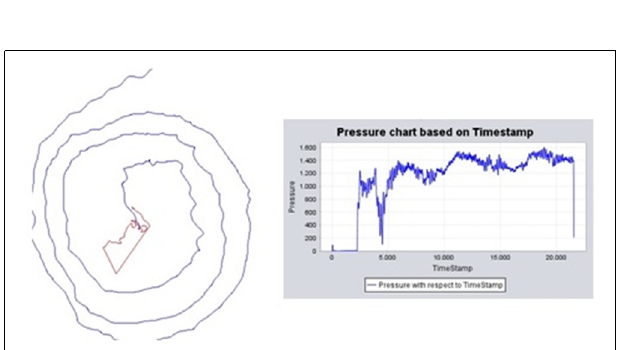
FIGURE 5 | Handwriting processing. (Left) Example of Archimedes’ spiral of an ET patient, trajectory on the surface (blue) and in-air (red), and pressure chart based on the time-stamp. (Right) Pressure chart across time.